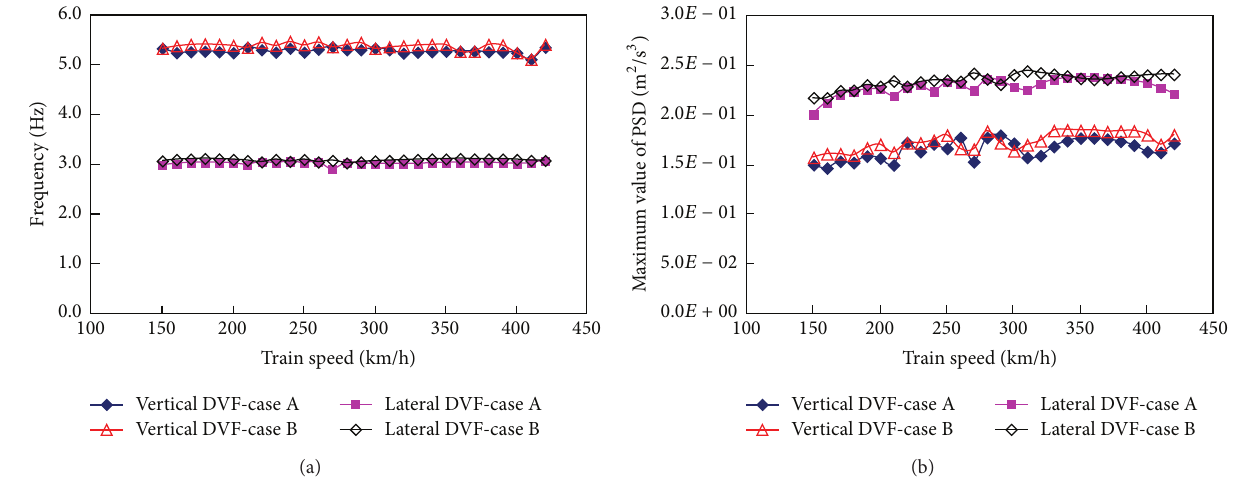
Figure 6: Girder midpoint acceleration with respect to train speed. (a) DVF. (b) Maximum value of PSD.